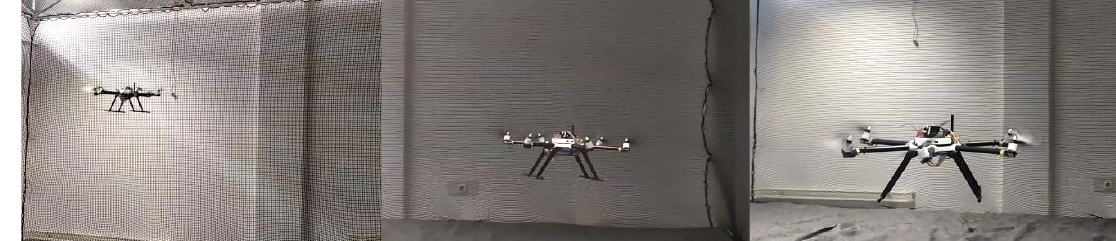
Figure 14. Experimental testing of remote control on PTX6.